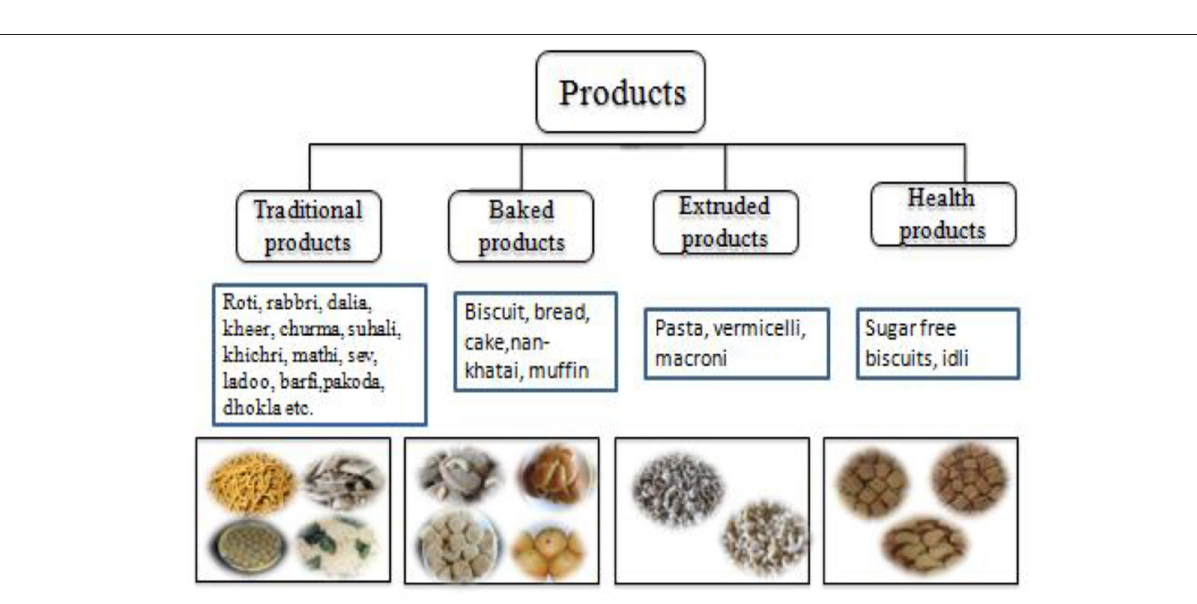
FIGURE 6 | Delicious and value-added food products from pearl